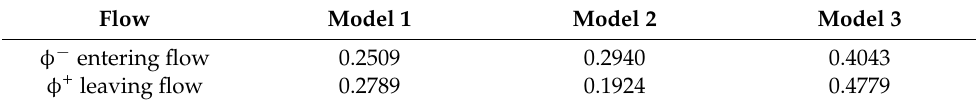
Table 10. Entering and leaving flows.